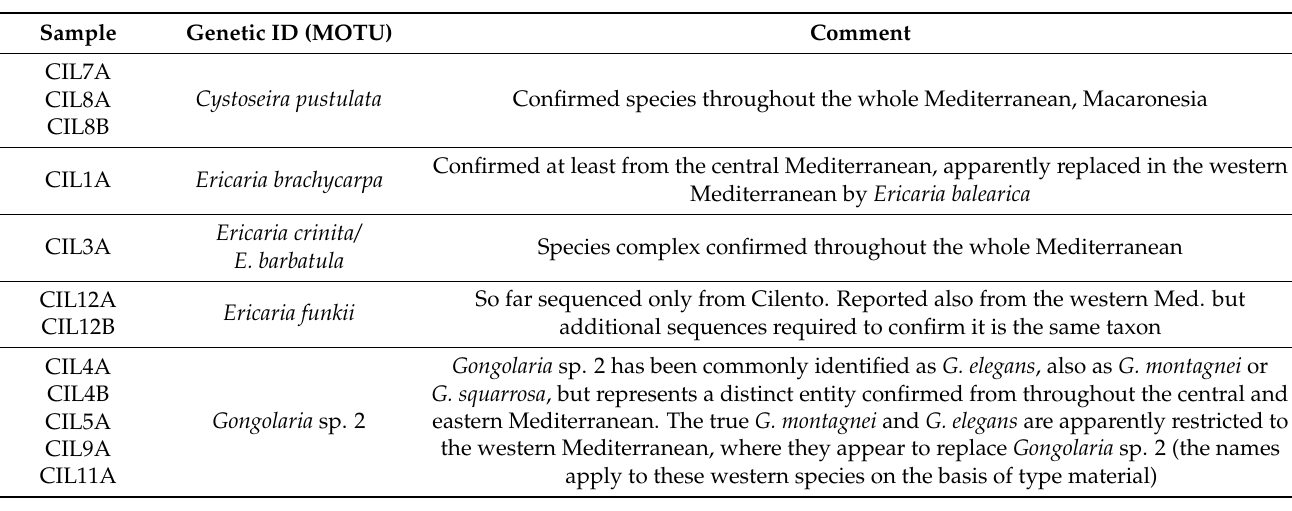
Table 1. Genetic identifications of Cystoseira s.l. samples from Cilento based on cox 1